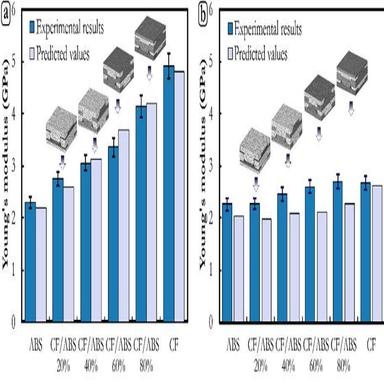
Comparison of experimental and predicted FGM specimens showing various volume fractions of ABS and CF/ABS materials, (a) specimens fabricated on XY plane, (b) specimens fabricated on XZ plane.